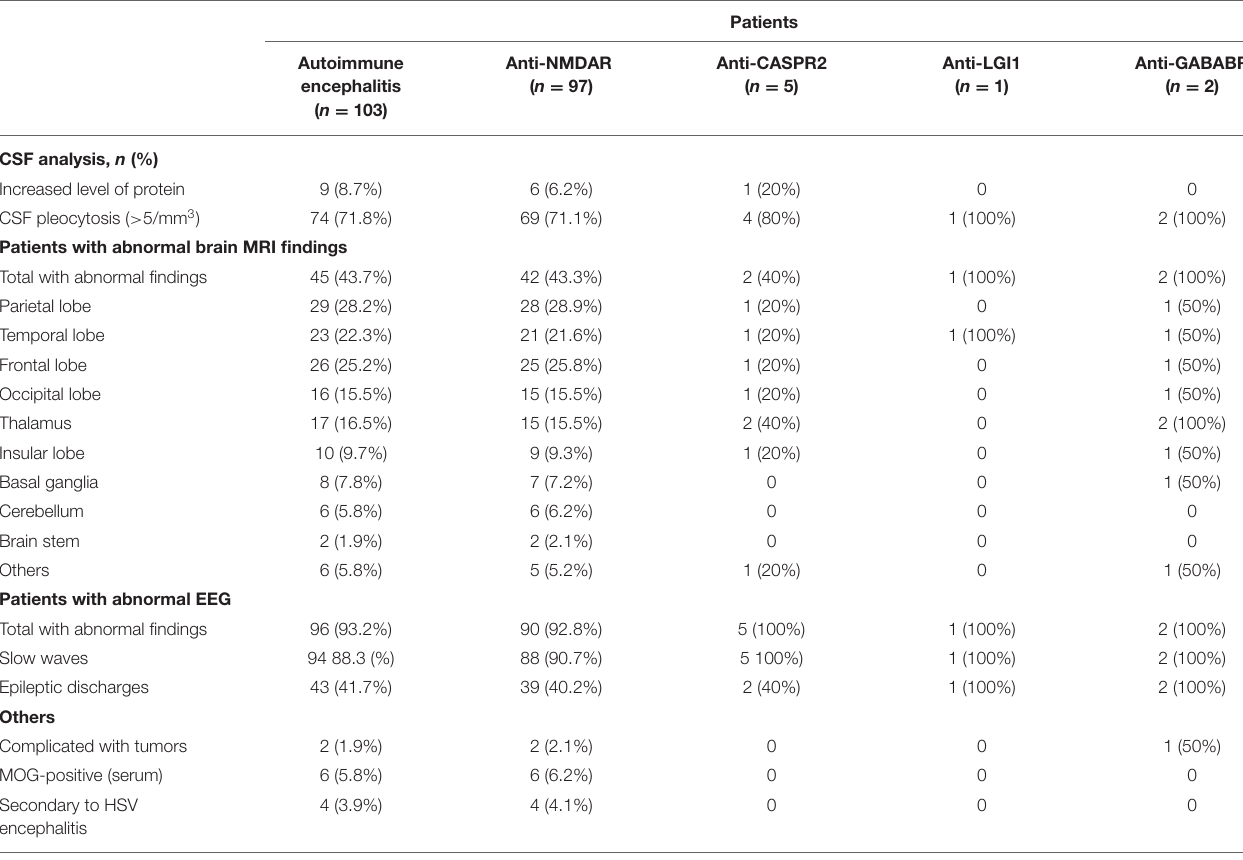
TABLE 2 | Auxiliary examinations of AE patients.